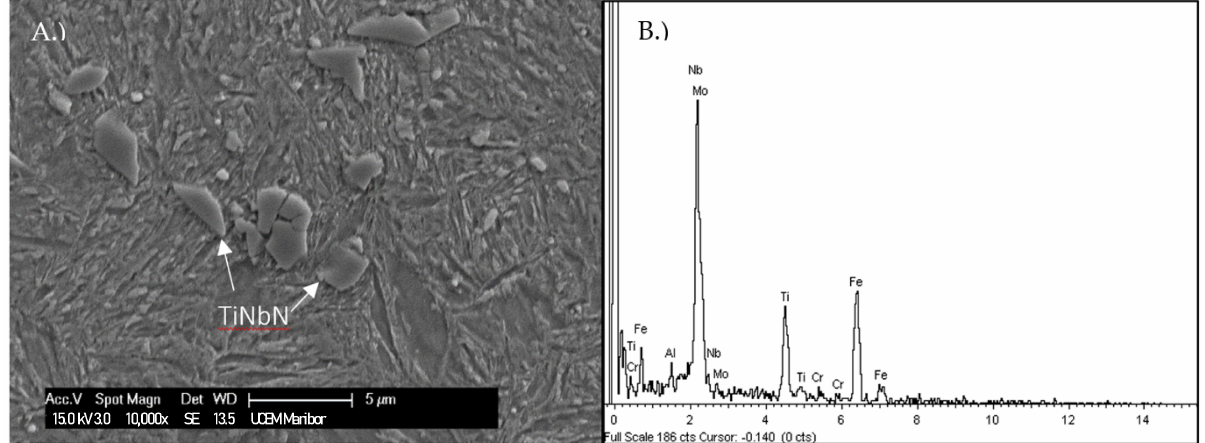
Figure 10. ( A ) Cluster of TiNbN inclusions adjacent to the fatigue crack, ( B ) corresponding EDX spectrum of the marked